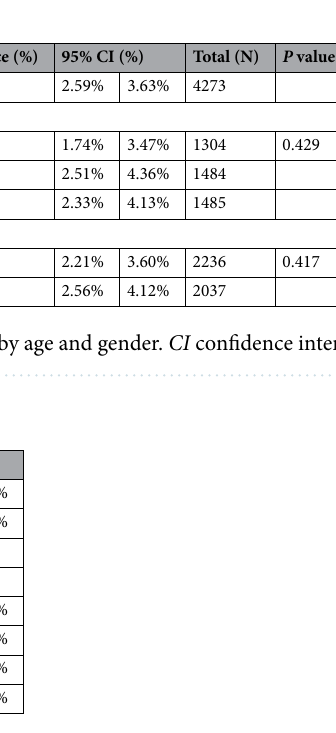
Table 2. Subtypes of Strabismus in Hong Kong children. CI confidence